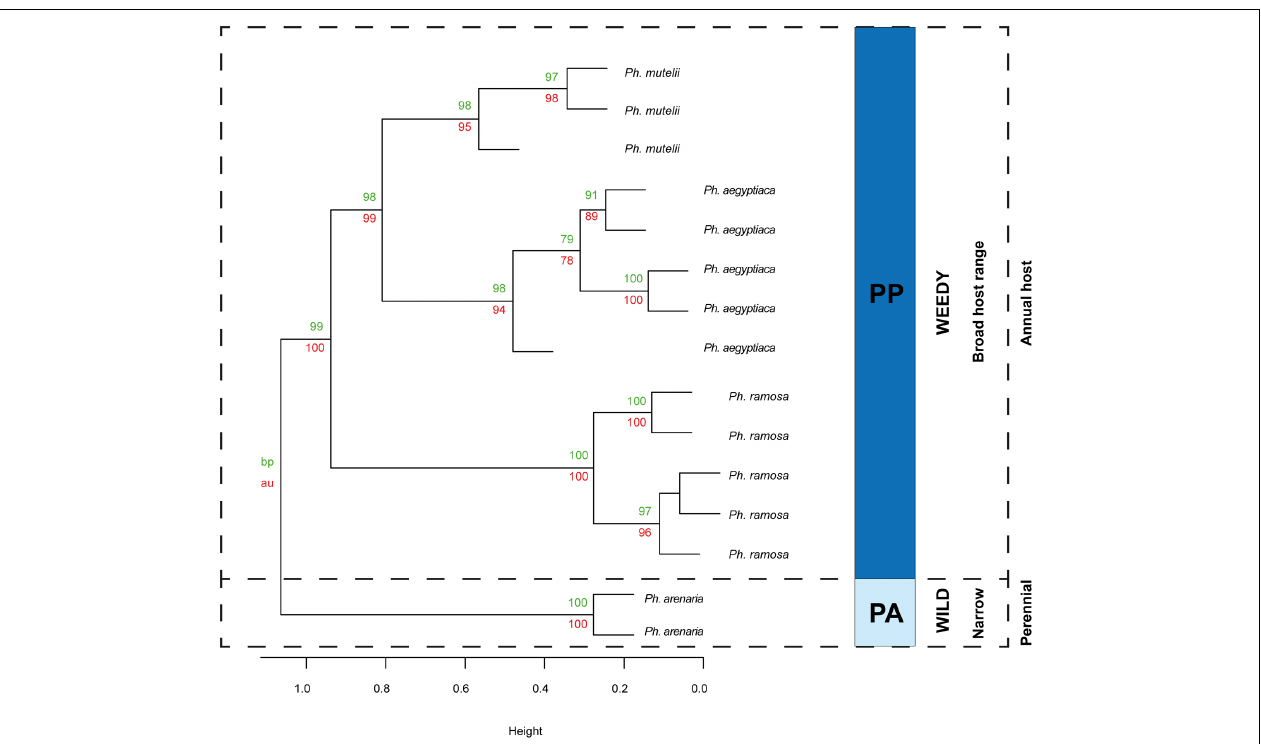
FIGURE 7 | Hierarchical clustering diagram of the flower VOC profiles of all broomrapes of the genus Phelipanche . HCA was performed with R and it was based on recalculated PCA using a subset with data of Phelipanche spp. only. Numbers at nodes are bootstrap probability P -value (BP, upper green numbers) and approximately unbiased P -values (AU, lower red numbers). Taxonomic grouping of the genus Phelipanche as proposed by Teryokhin (1997) is shown by letters and colors which indicate sections, PP, Phelipanche and PA,